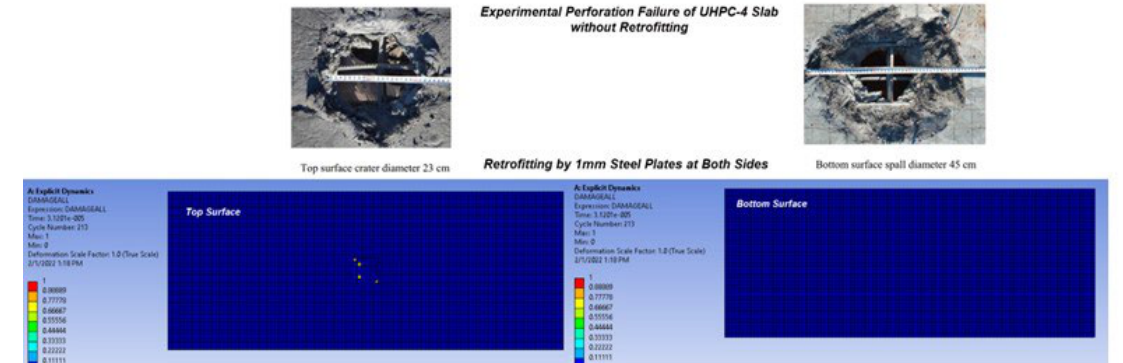
Figure 17 – Comparison between mode of failure of experimental non-retrofitted UHPC-4 Slab and retrofitted one by 1 mm steel skin plates at top & bottom surfaces